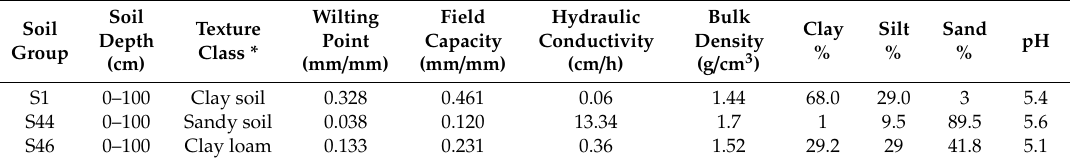
Figure 1. Average monthly climatic data of Khon Kaen (KK) between 1980–2010; Rain: mean monthly rainfall (mm); Radn: mean daily solar radiation (MJ/m 2 ); Maxt: mean daily maximum temperature (°C); Mint: mean daily minimum temperature (°C). Table 1. Physical and chemical properties of selected soil types of KK [4].